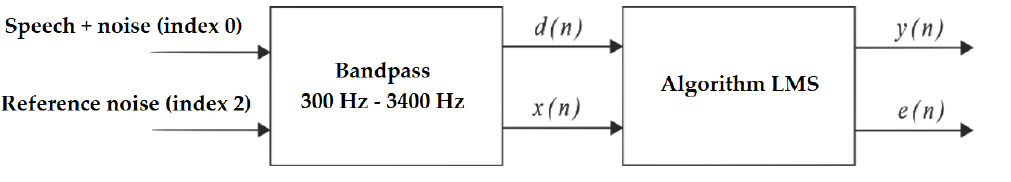
Figure 7. Filtration measuring chain for the LMS algorithm.